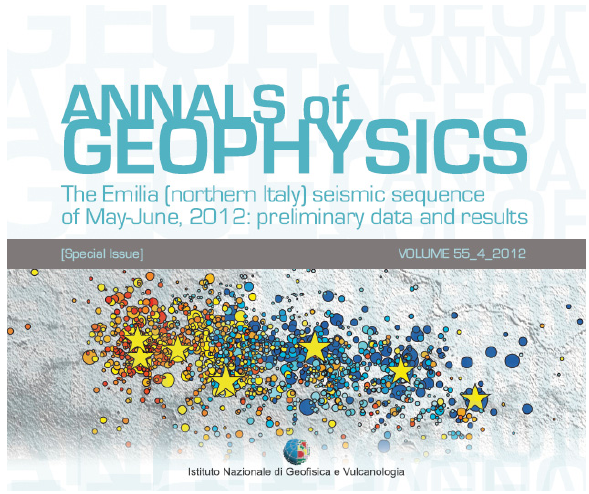
Figure 2. Cover of the Annals of Geophysics fast track issue on the Emilia (northern Italy) seismic sequence of May-June, 2012.